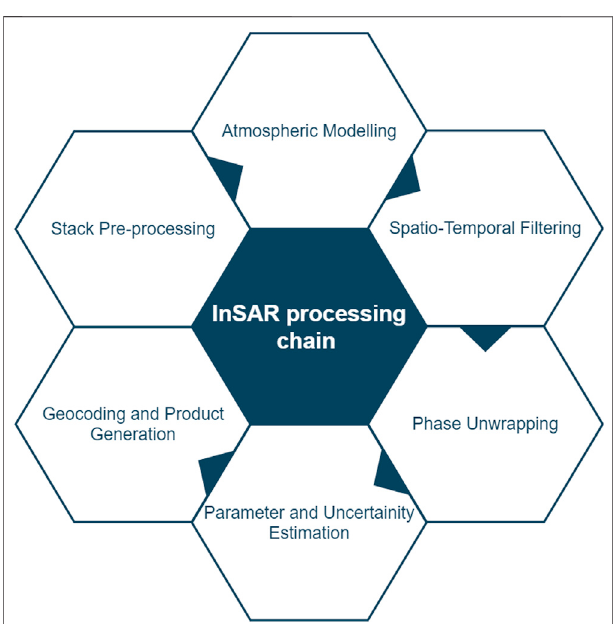
FIGURE 4 | Stacking InSAR processing chain used for the